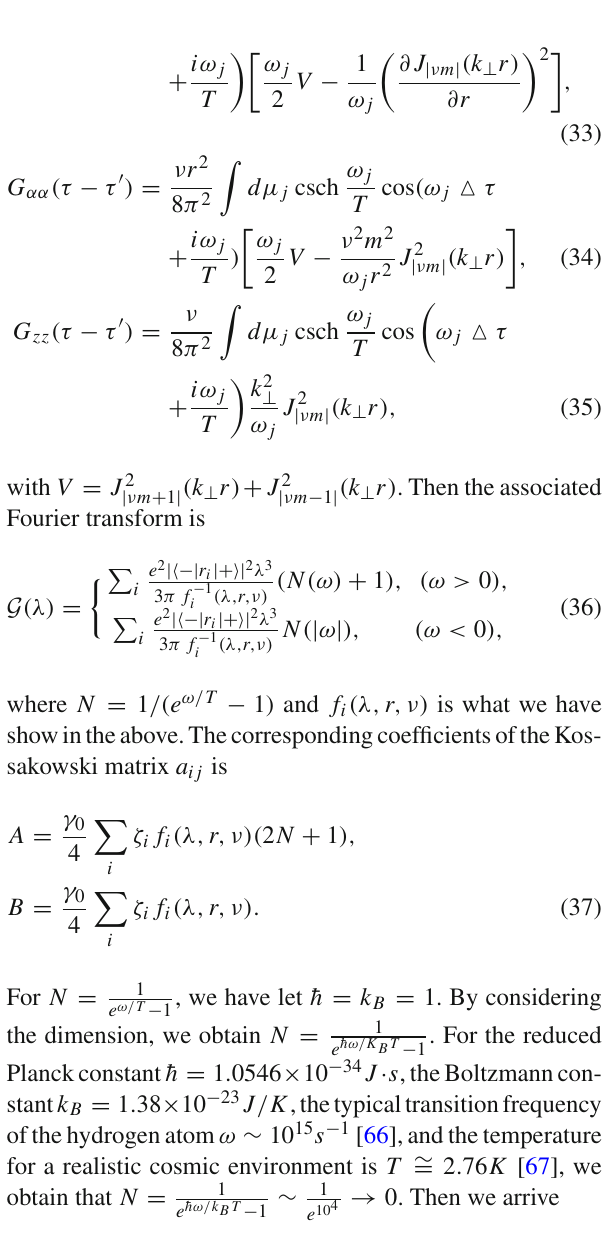
Fig. 6 QFIofthedeficitangleparameter ν asafunctionofitselfandthe effectivetime τ withfixedvalueoftheinitialstateparameter θ = 0.The left to right panels correspond to the radial polarization (ζ r ,ζ α ,ζ z ) = ( 1 , 0 , 0 ) , the tangential polarization (ζ parallel polarization (ζ r ,ζ α ,ζ z ) = ( 0 , 0 , 1 ) , respectively. We take the